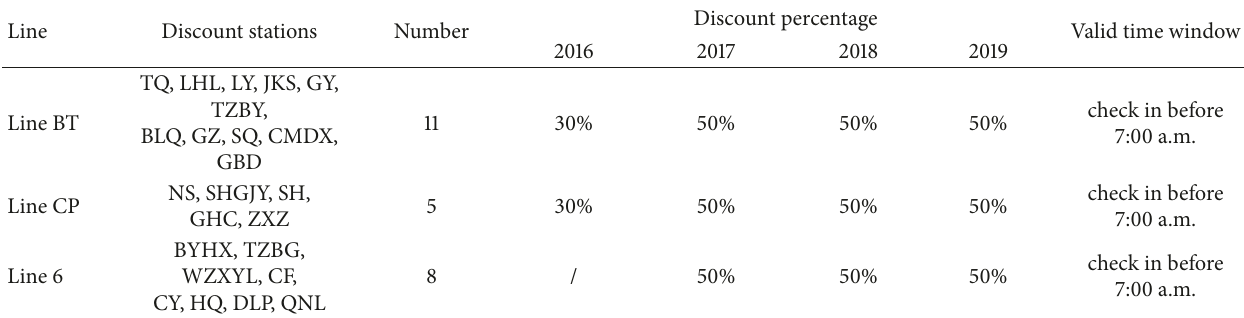
Table 2: Prepeak discount price scheme in the Beijing